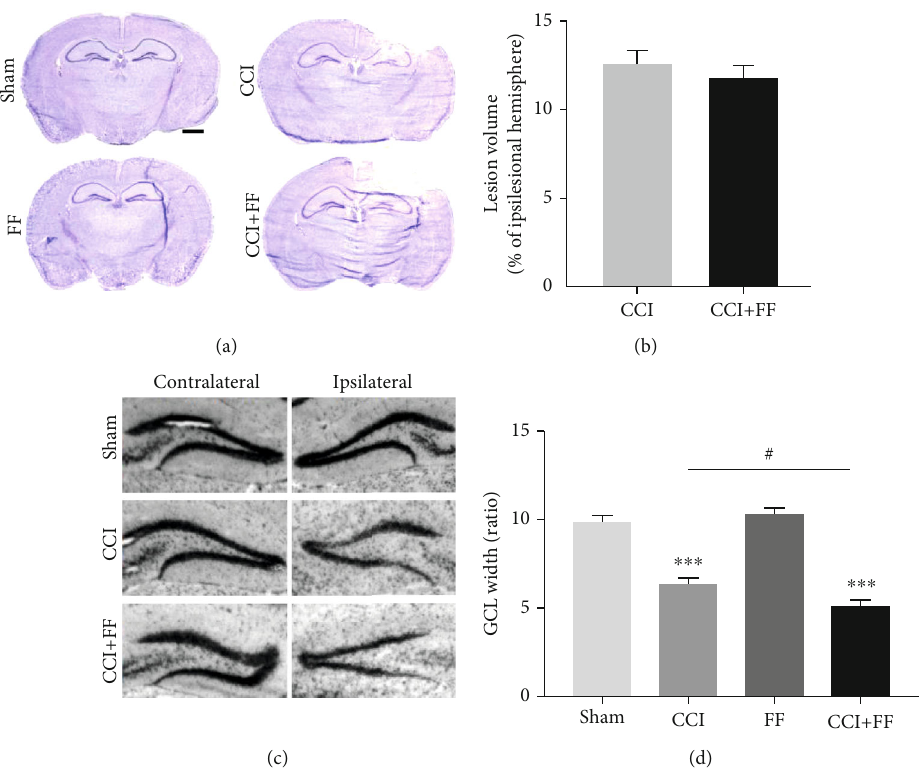
Figure 2: Femoral fracture increases structural brain damage after TBI. (a) Representative images of cresyl violet-stained brain sections, bregma -2.00mm. Scale bar: 1mm. (b) Lesion volume expressed as percentage of the ipsilesional hemisphere was not signi fi cantly altered in CCI versus CCI+FF mice. (c) Representative images of ipsi- and contralateral dentate gyrus of sham, CCI, and CCI+FF mice, bregma -2.00mm, showing substance loss in the granular cell layer (GCL). (d) GCL width was determined in the suprapyramidal blade and calculated as ipsi- to contralateral ratio. CCI and CCI+FF showed reduced ratios compared to sham and FF, indicating a posttraumatic substance loss of ipsilesional GCL after CCI. CCI+FF showed signi fi cant reduction of GCL width compared to isolated CCI. ∗ Di ff erences of CCI or CCI+FF compared to FF or sham, # di ff erences between CCI and CCI+FF. Values represent mean ± SEM ; p values were calculated by Student ’ s t -test (b) and Holm-Sidak ’ s multiple comparison test